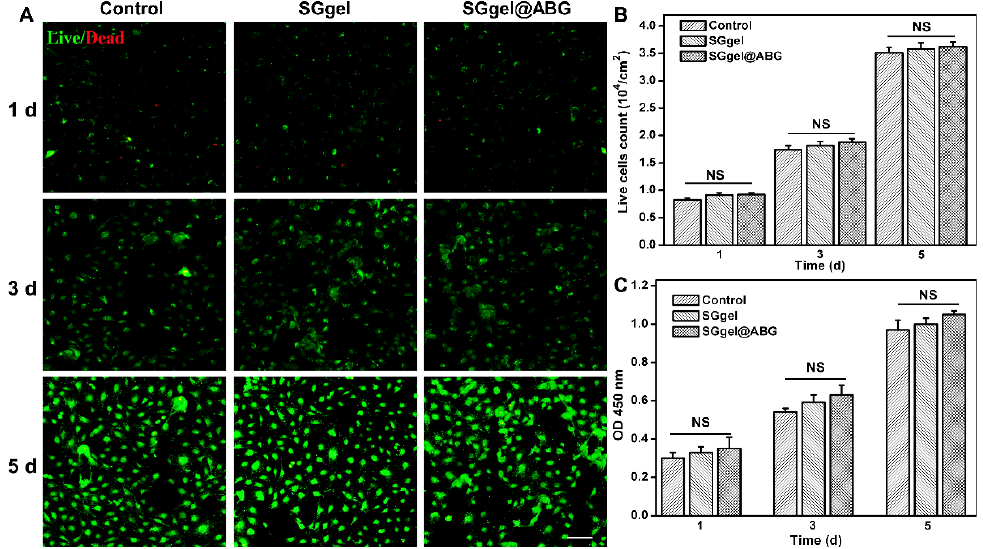
Figure 3. Cell cytotoxicity of SGgel and SGgel@ABG hybrid scaffolds in vitro . ( A ) Live/dead staining of BMSCs. Wherein, the green cells are the living BMSCs, and the red cells are the dead BMSCs. ( B ) Cell viability and ( C ) Cell proliferation of SGgel and SGgel@ABG hybrid scaffolds after the cultivation for the appointed time. NS, not